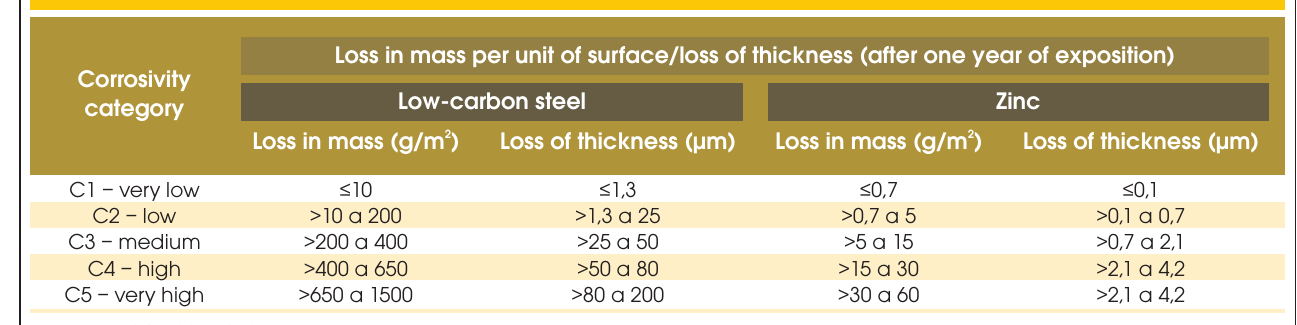
Table 1 – Indicatives rates of corrosion for different environmental